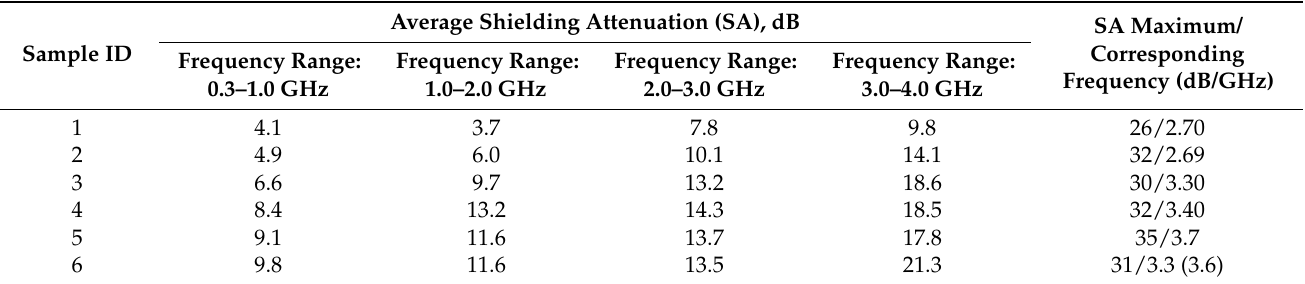
Table 3. Frequency dependence of the shielding attenuation of films based on different carbon